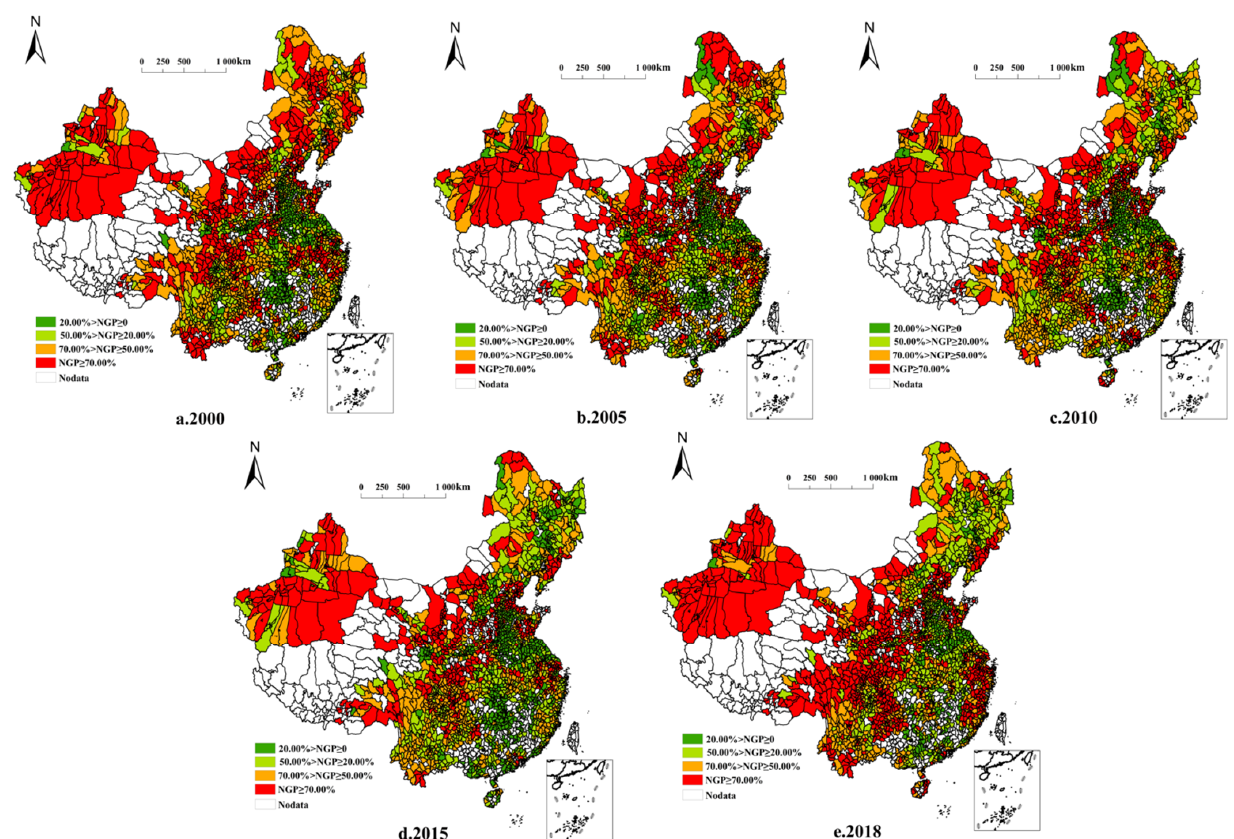
Figure 1. Non-grain production rate of 2323 county-level units in China from 2000 to 2018.